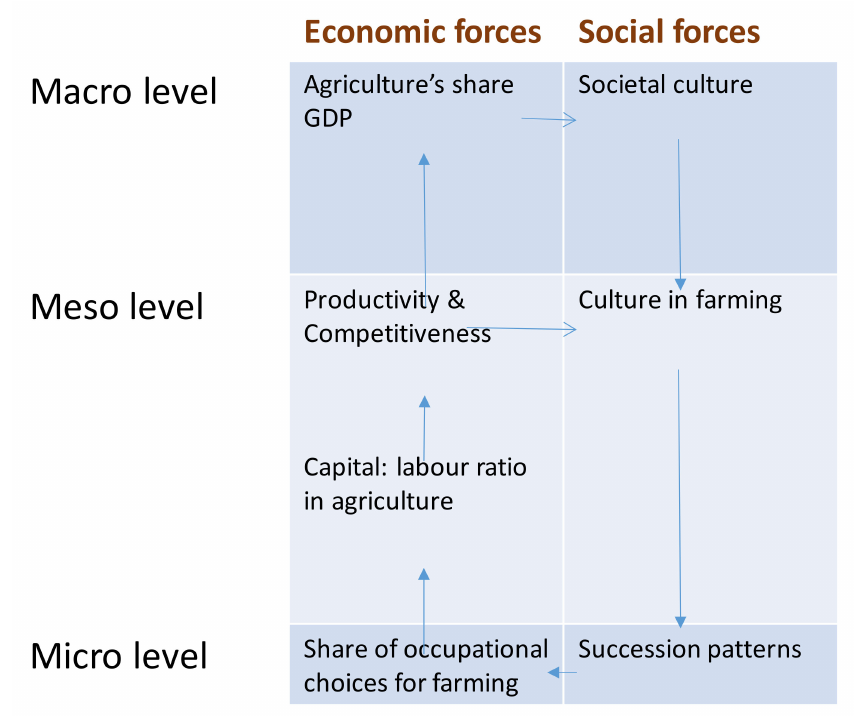
Figure 3. A socioeconomic approach to structural change in